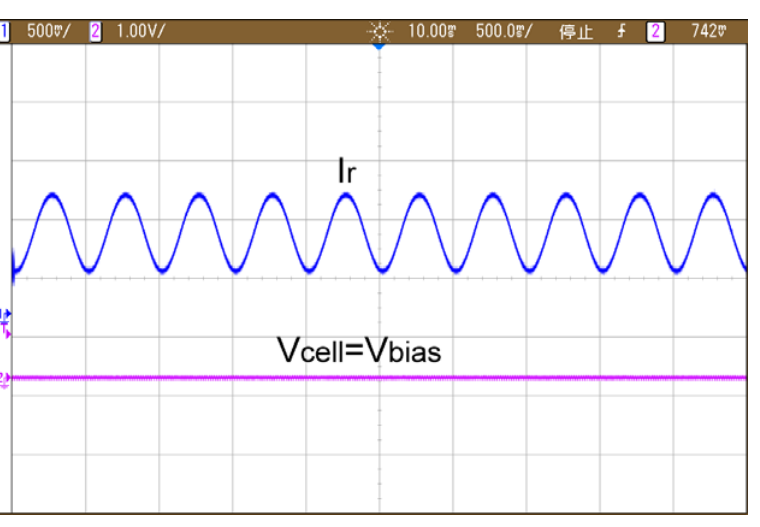
Figure 11. Photomicrograph of single-ended potentiostat.